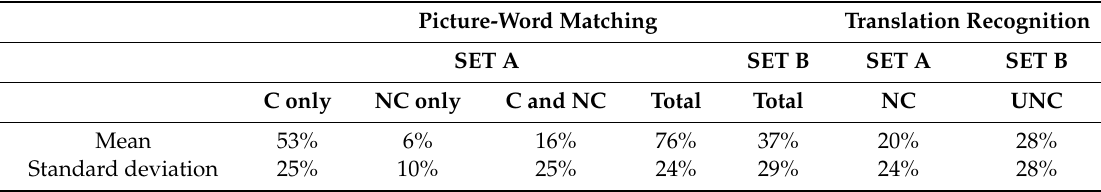
Table 1. Mean percentages of correct responses given to each condition in both recognition tasks. Standard deviation values are displayed in the second row for each condition in each task. Picture-Word